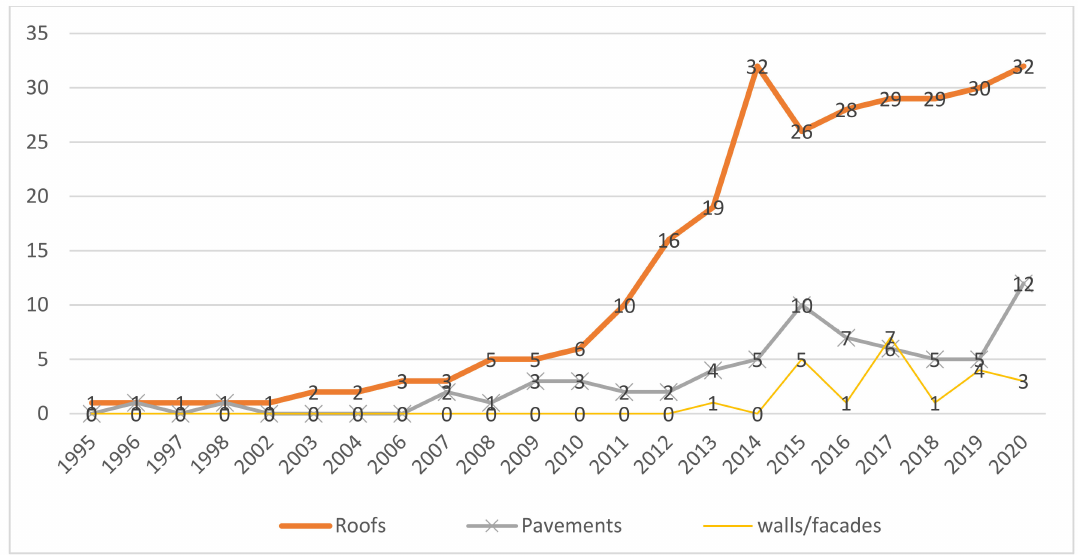
Figure 4. Evolution of cool material application domain: roofs, pavements, and